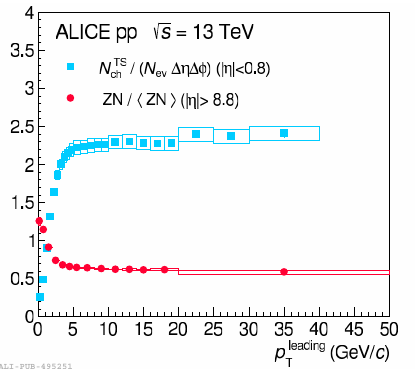
(at mid-pseudorapidity) in pp collisions at T